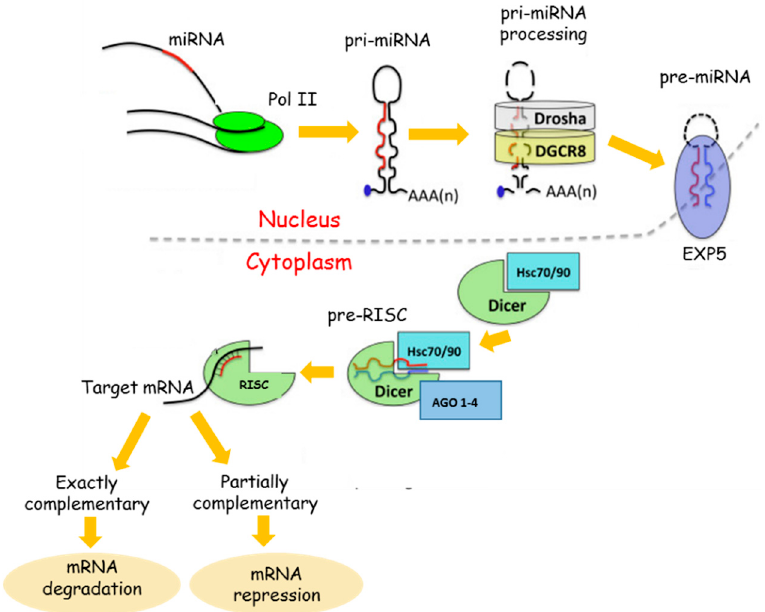
Figure 1. miRNA Biogenesis. The long primary miRNA (pri-miRNA) with its hairpin structure is processed by the Drosha-DCGR8 complex. The microprocessor complex, formed by Drosha and its cofactor DCGR8, leads to the maturation of the pri-miR into precursor miRNA (pre-miRNA). After Drosha processing, pre-miRNAs are exported into the cytoplasm by Exportin 5 (EXP). In the cytoplasm, another RNase guides the maturation of pre-miRNA into the duplex form, i.e., Dicer. Dicer interacts with the double-strand hairpin structure of the cytosolic pre-miRNA and, in collaboration with RNA-binding protein, cleaves the RNA duplex. Further, the mature miRNA, the red strand, is loaded directly into the RNA-induced silencing complex (RISC), whereas the passenger miRNA, the blue strand, is usually degraded. The RISC complex needs the help of two heat shock cognate proteins (HSC70 and 90) that mediate the opening of the argonaute (AGO) protein to receive the miRNA duplex. The RISC receives the duplex, unwinds it, and degrades the passenger miRNA. The pairing between the RISC-mature miRNA and the seed sequence on the target mRNA determines mRNA degradation or mRNA repression. Adapted from Cava et al. [28].